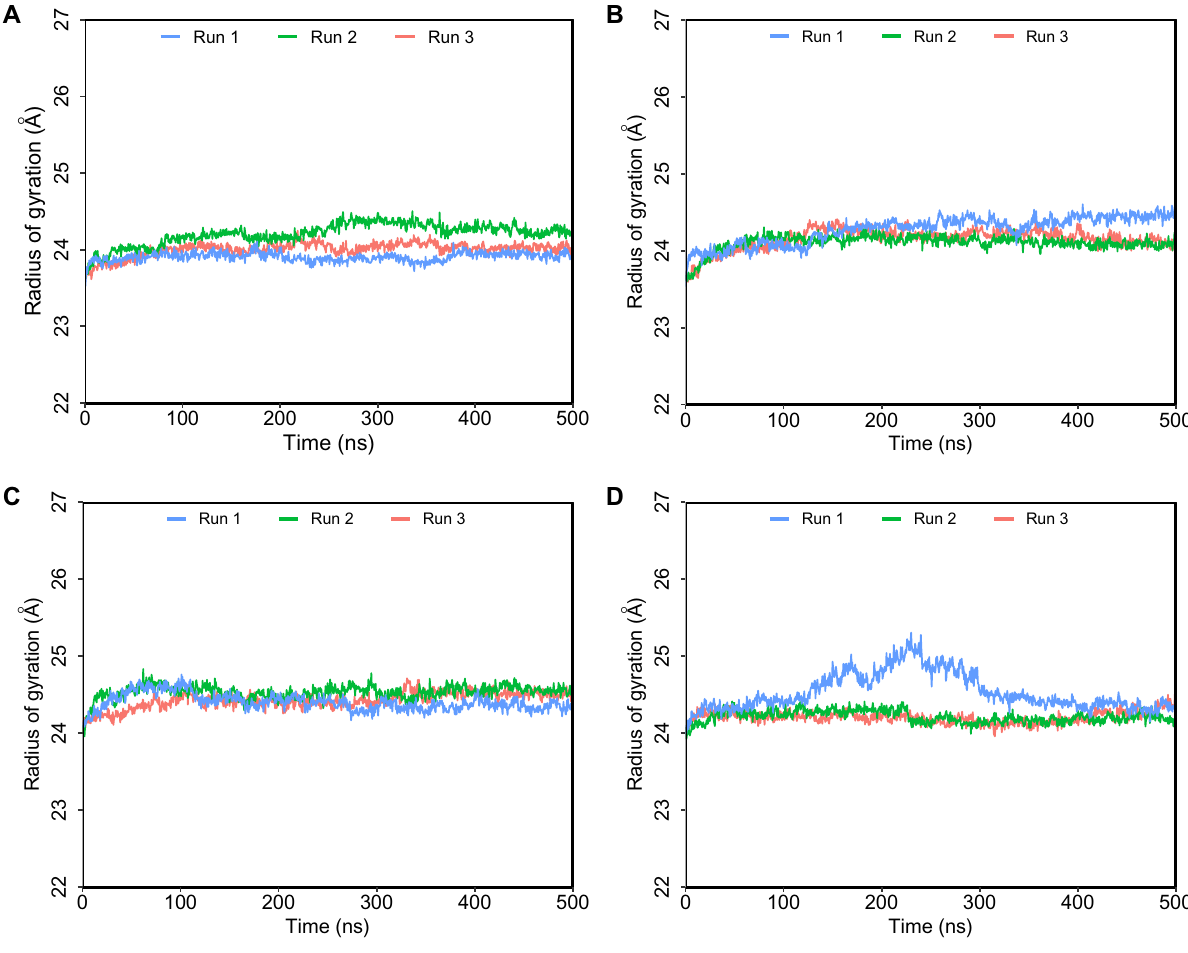
Figure 5. Radius of gyration (Rg) of hemorphin peptides from 500 ns simulations. ( A ) Camel LVVHem6 with ACE1 ( B ) LVVHem6 with ACE1 ( C ) Camel LVVHem6 with ACE2 ( D ) LVVHem6 with